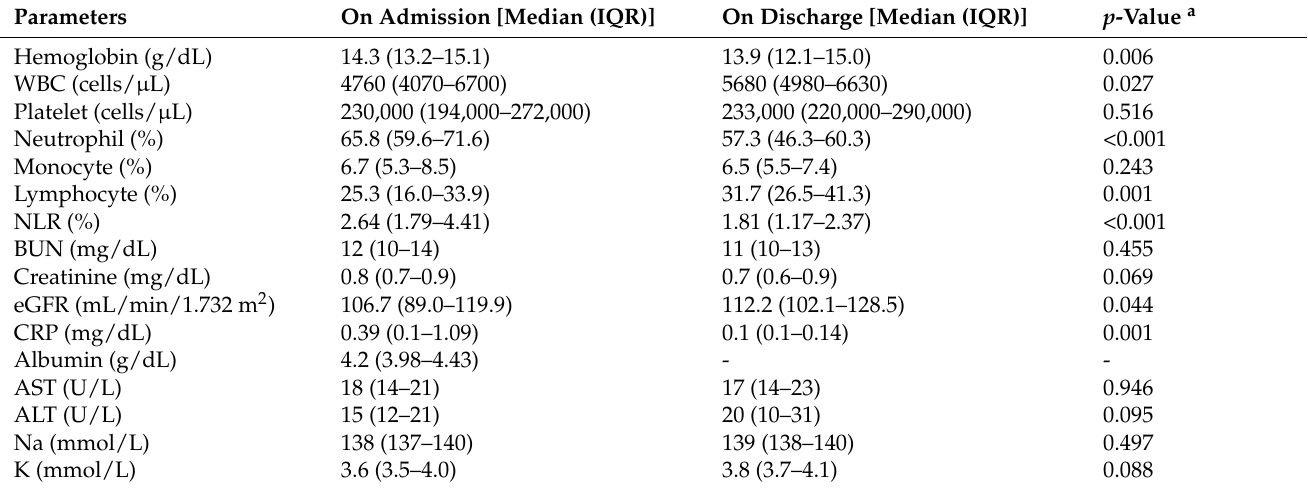
Table 4. Laboratory findings ( n =